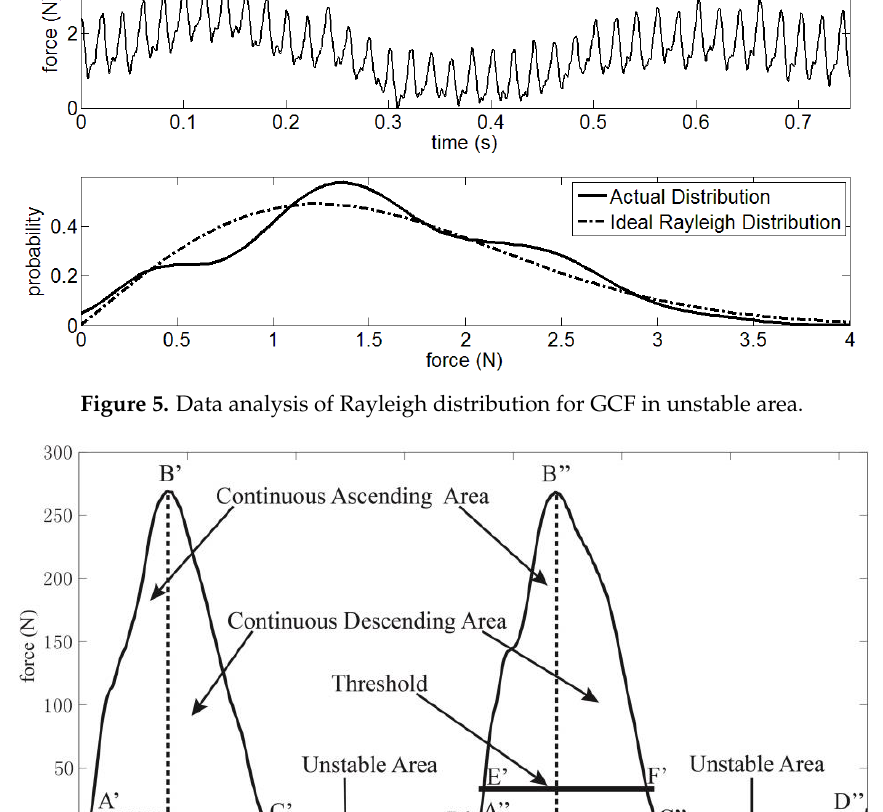
Figure 6. For the first gait cycle, the sliding window detector divides GCFs into continuous ascending area, continuous descending area and unstable area. The GCFs in the unstable area from the first gait cycle are used to compute a threshold for the next gait cycle according to the CFAR.